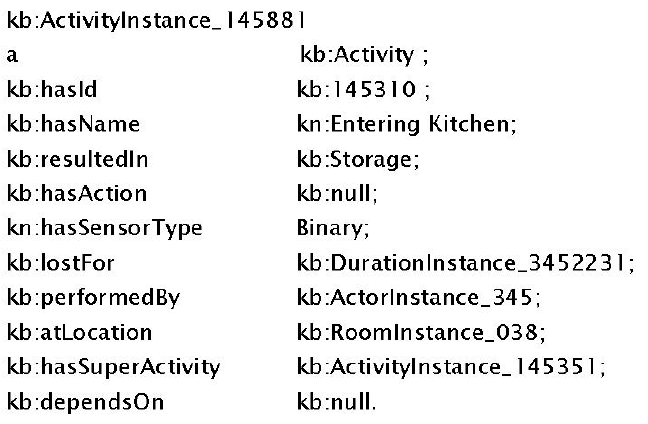
Figure 7. Ontological representation of activity in N3 notation.